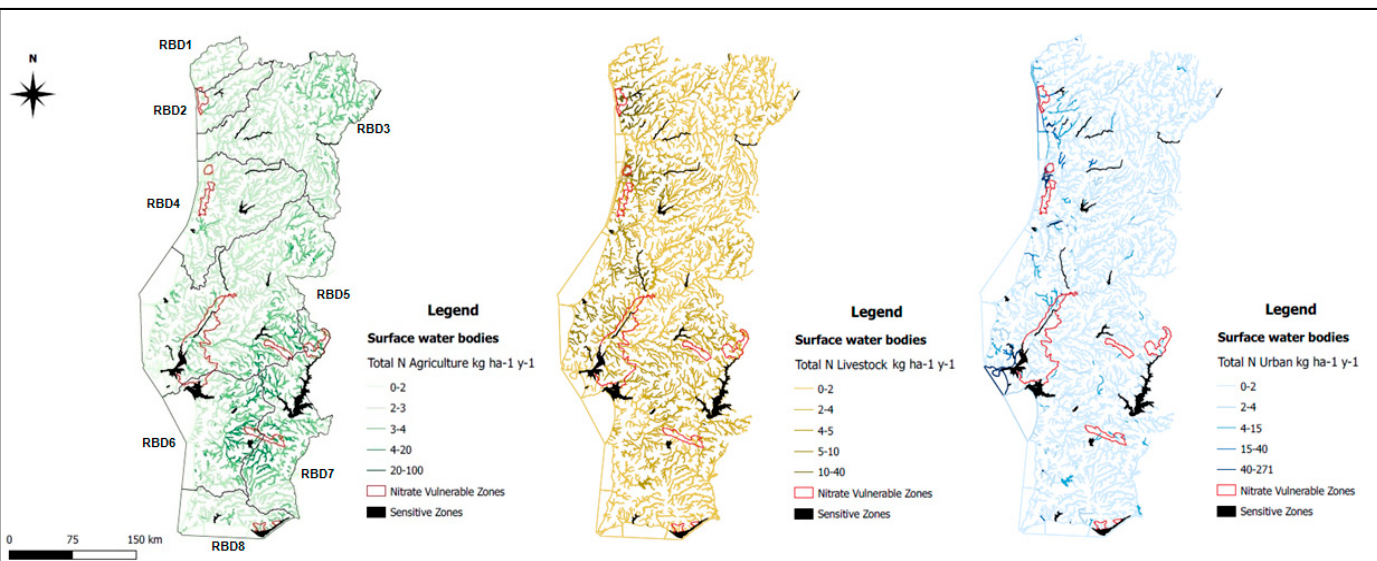
Figure 2. Total N loads from agriculture ( left ), livestock ( center ) and urban ( right ) sources to surface waters in 2015 (kg ha − 1 y − 1 ) in mainland Portugal in Datum 73/UTM 29N. Designated Nitrate Vulnerable Zones (NVZ) (red closed lines) and Sensitive Zones (SZ) (shaded in black) are also shown. River Basin Districts (RBD) (1 to 8) are display on the agricultural pressures map ( left ) limited by grey lines: RBD1—Minho e Lima rivers (NVZ1); RBD2—Cávado, Ave e Leça rivers; RBD3—Douro river; RBD4—Vouga, Mondego and Lis rivers (NVZ2); RBD5—Tagus river (NVZ5 and NVZ7); RBD6—Sado e Mira (NVZ4); RBD7—Guadiana (NVZ6); RBD8—Algarve rivers (NVZ3 and NVZ8) [6,18,35].